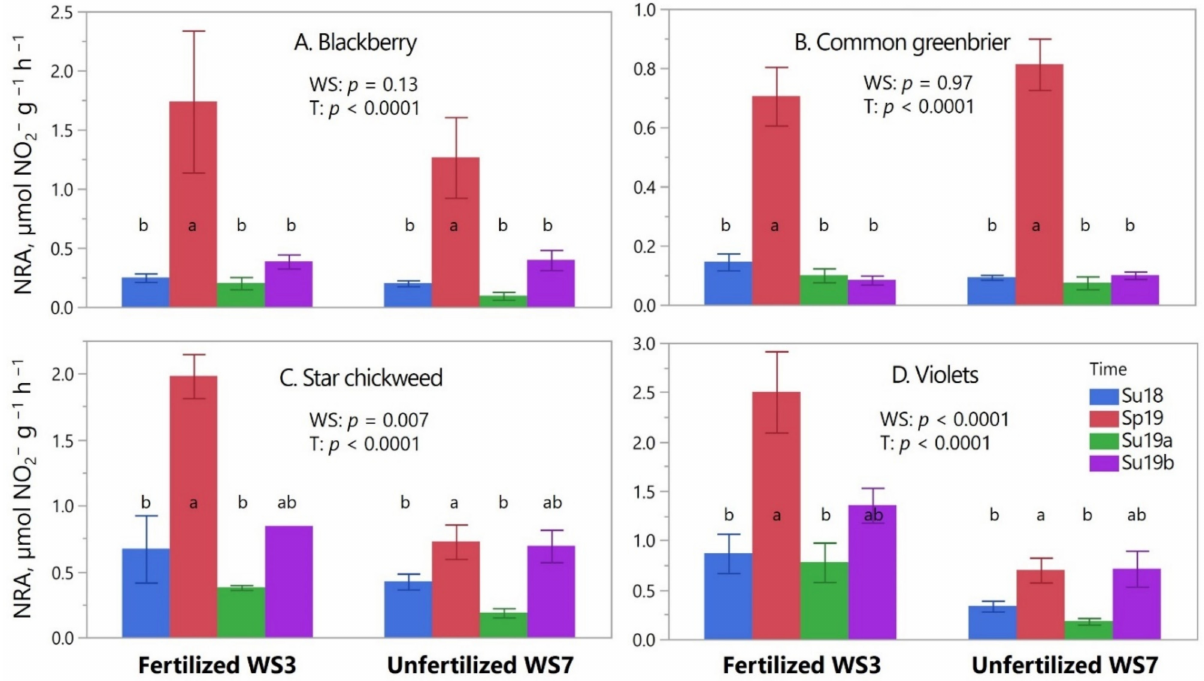
Figure 2. Mean NRA of herb-layer species A ) blackberry, B ) common greenbrier, C ) star chickweed, D ) violets collected during one spring and three summer campaigns; summer 2018 (Su18), spring 2019 (Sp19), early summer 2019 (Su19a), and midsummer 2019 (Su19b), in fertilized watershed (WS) 3 and unfertilized WS7 at the Fernow Experimental Forest, West Virginia, USA. Values for model effects Watershed (WS) and Time (T) are displayed per species; WS × T interactions were not significant. Note the different scales of the y-axes. Error bars represent 1 SE based on a maximum of n = 9 for spring (i.e., the number of sites per watershed) and n = 18 (i.e., the number of plots per watershed). Letters (from Tukey–Kramer multiple comparisons) are showing the Time effect; means not connected by the same letter are significantly